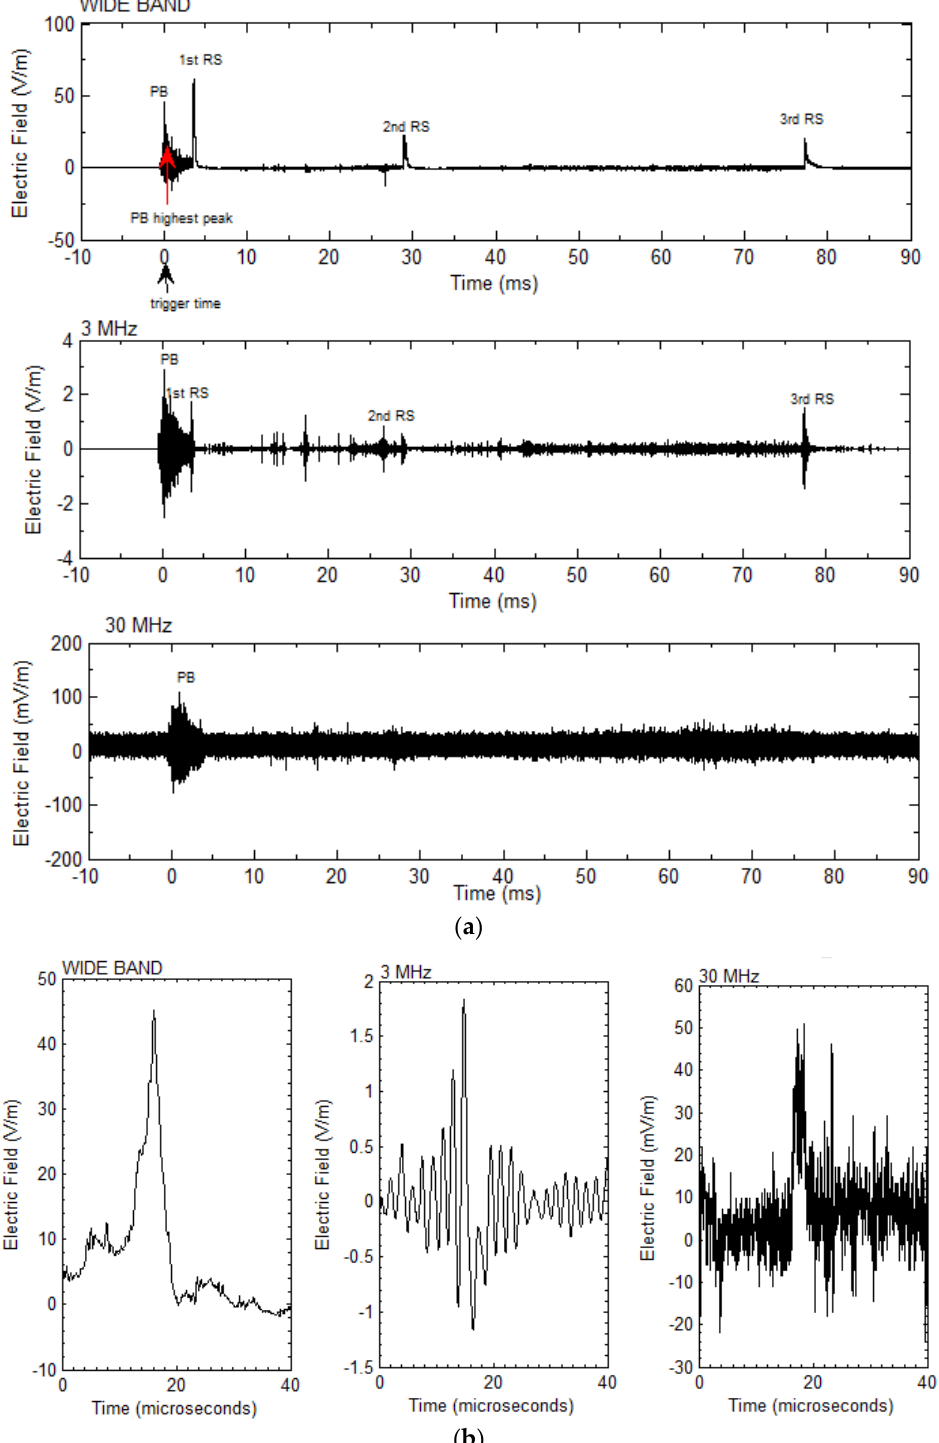
Figure 2. Wideband PB pulse train together with 3 and 30 MHz recorded in 21/07/2014 at 16:48:02:497955 for negative cloud-to-ground flash. The strike location (59.79490 ˝ N, 17.64630 ˝ E) was located at a distance of about 7 km from the measuring station. ( a ) Record of the whole flash; ( b ) Portion of the PB pulse train with maximum amplitude (zoomed from 2a). Note that the zoomed pulse starts at the trigger time, zero and ends 40 µ s